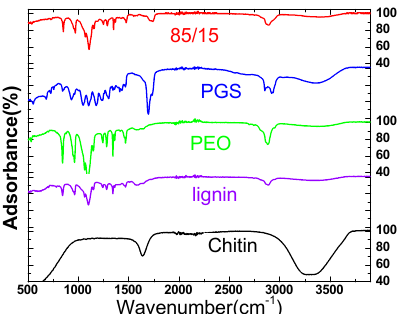
Figure 2. FTIR spectra of the hybrid fiber with 15 vol % of PGS solution (85/15) and its individual components. Materials 2018 , 11 , x FOR PEER REVIEW